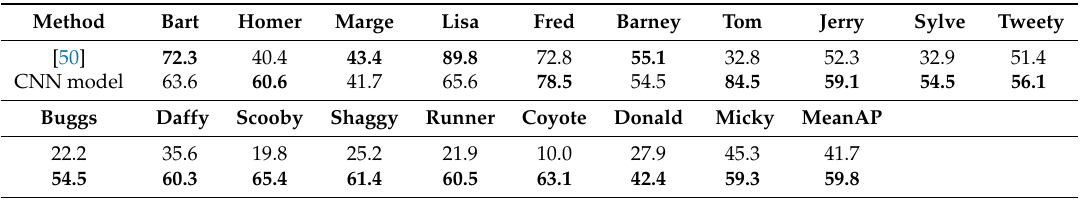
Table 3. The mAP results on Fahad18